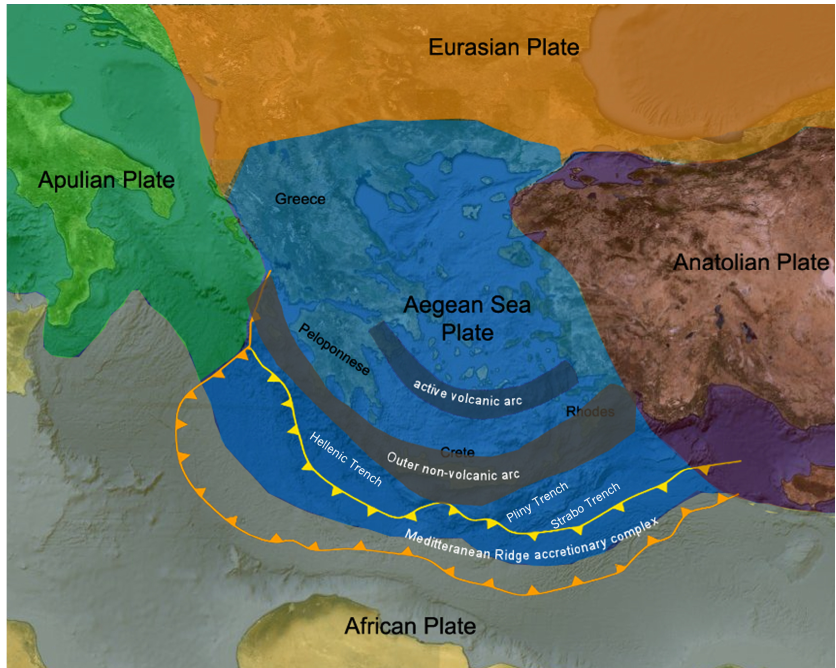
Figure 1. Geological background of Greece. The figure shows the seismic plates that surround Greece and the Trenches in yellow and